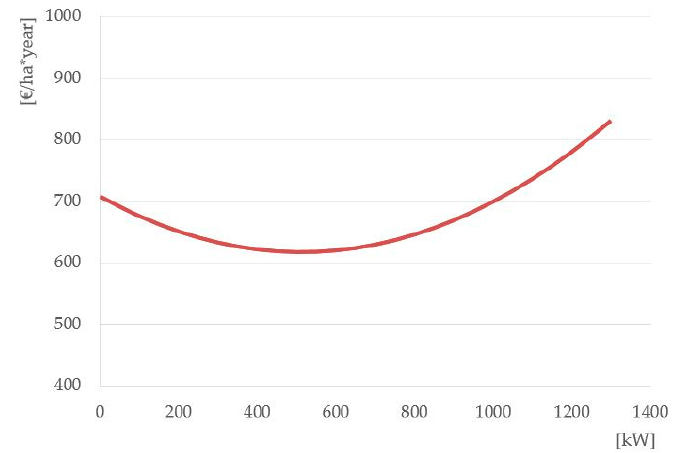
Figure 4. Function of the average plants’ power in a municipality on rental price ( pp_m ).